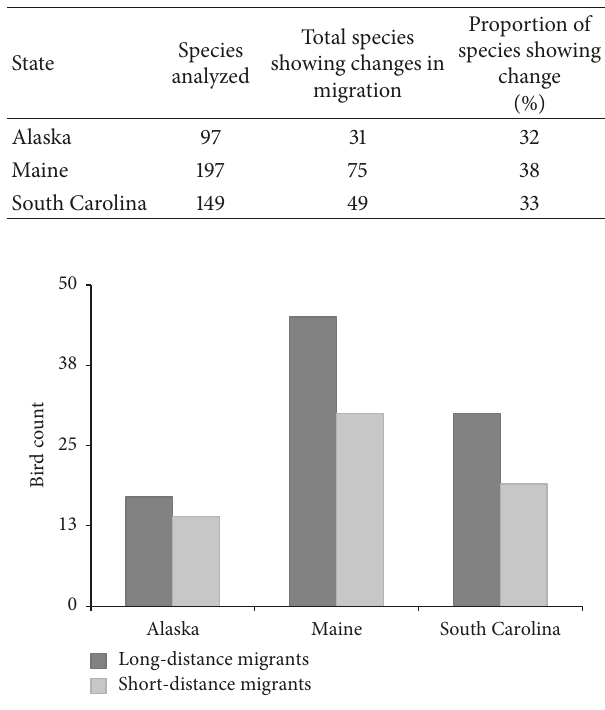
Figure 2: Number of long-distance and short-distance migrant species showing changes in migration patterns due to changing temperatures or over time during 2010–2016 in Alaska, Maine, and South